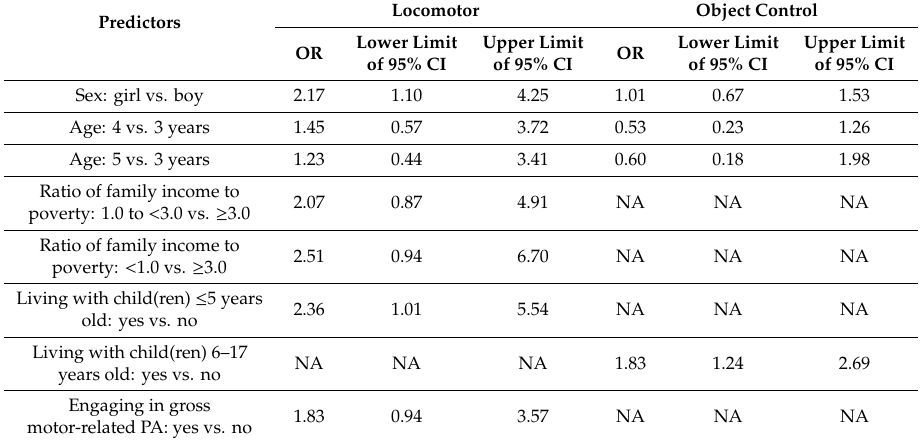
Table 5. Odds ratios of a higher locomotor score and a higher object control